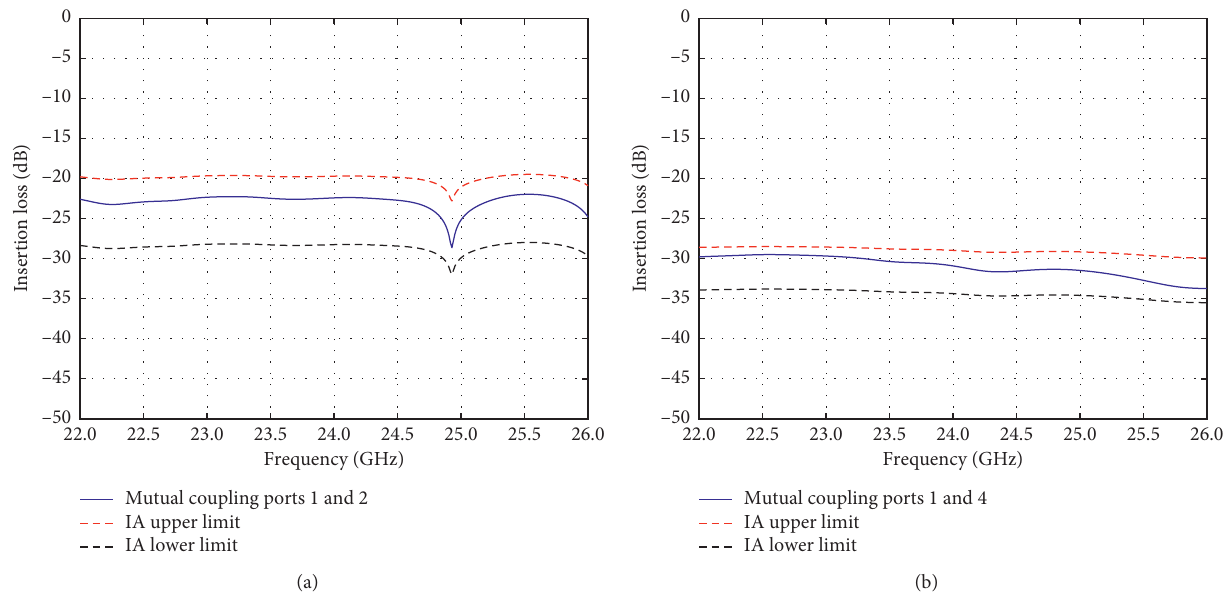
Figure 18: K-band Rotman lens: coupling factor vs. frequency (a) between ports P1 and P2 and (b) between ports P1 and P6.